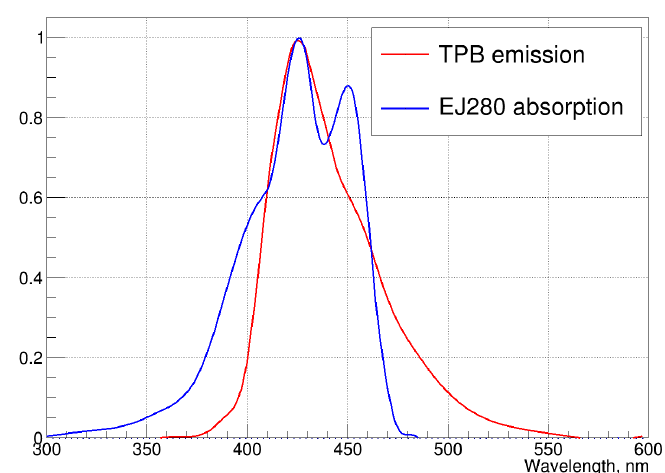
Figure 4. TPB emission spectrum [16] and WLS absorption spectrum [17] (both in a.u.) are well matched.